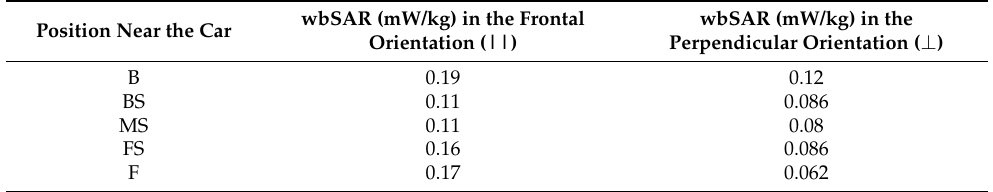
Table 1. The wbSAR across human model positions in the frontal and perpendicular orientations. Position Near the